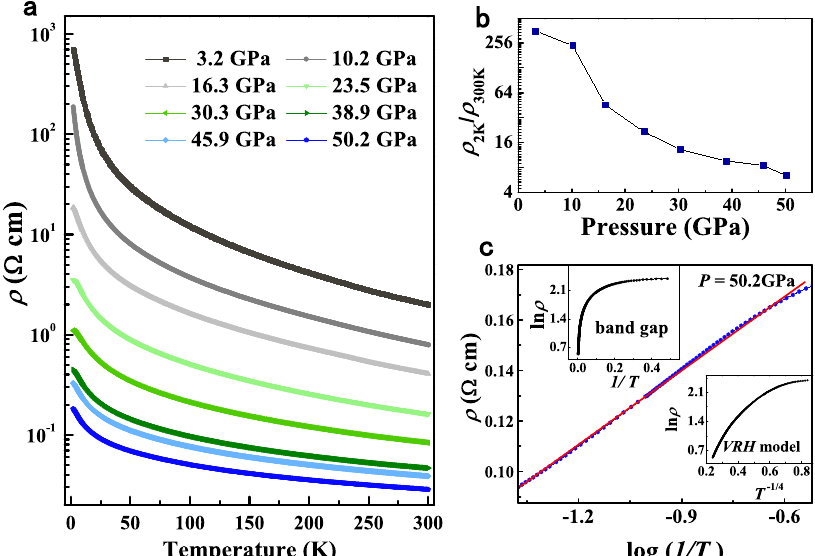
Fig. 5 Temperature dependent resistivity of Nd 0.8 Sr 0.2 NiO 2 under pressures. a Temperature dependence of resistivity for Nd 0.8 Sr 0.2 NiO 2 at various pressures. b The applied pressure dependence of ρ 2K / ρ 300K for Nd 0.8 Sr 0.2 NiO 2 sample derived from the ρ − T curve at different pressures. c The ρ versus ln(1/ T ) curve for Nd 0.8 Sr 0.2 NiO 2 in the temperature range from 3.5 to 23 K at the pressure of 50.2 GPa together with the corresponding linear fi t (red line). The top inset shows the curve of ln ρ versus 1/ T , corresponding to band gap model. The bottom inset shows the curve of ln ρ versus T − 1/4 , corresponding to the VRH pressure and show the fi tting in Fig. 5c. The fi tting curves of band gap model (the top-left inset) and VRH model (the bottom-right inset) are given. The results show that both the band gap model and the VRH model fail to fi t the data. Surprisingly, the ρ versus log(1/ T ) curve at the highest pressure ( P = 50.2 GPa) becomes